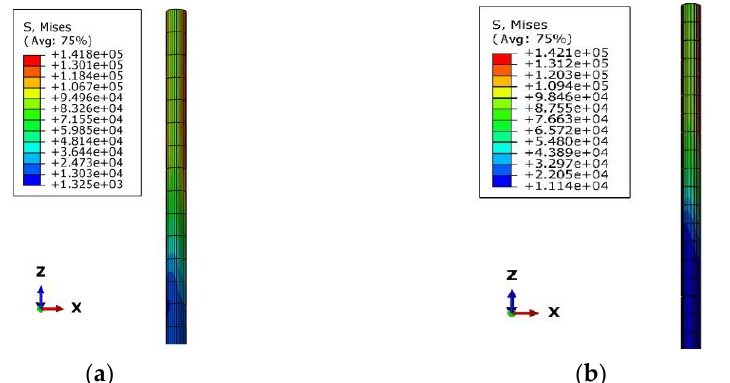
Figure 9. The lateral deformation along the conductor axial direction, where ( a ) is the result calculated by the contact surface model and ( b ) is that calculated by the Goodman contact element model.